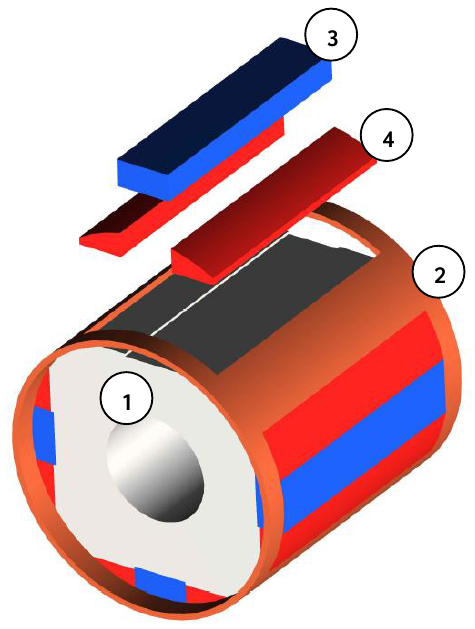
Figure 9. The designed rotor: 1: Soft magnetic composite core, 2: Copper cage, 3: Sm-Co magnet, 4: Nd-Fe-B bonded magnet, packet length: 56 mm.